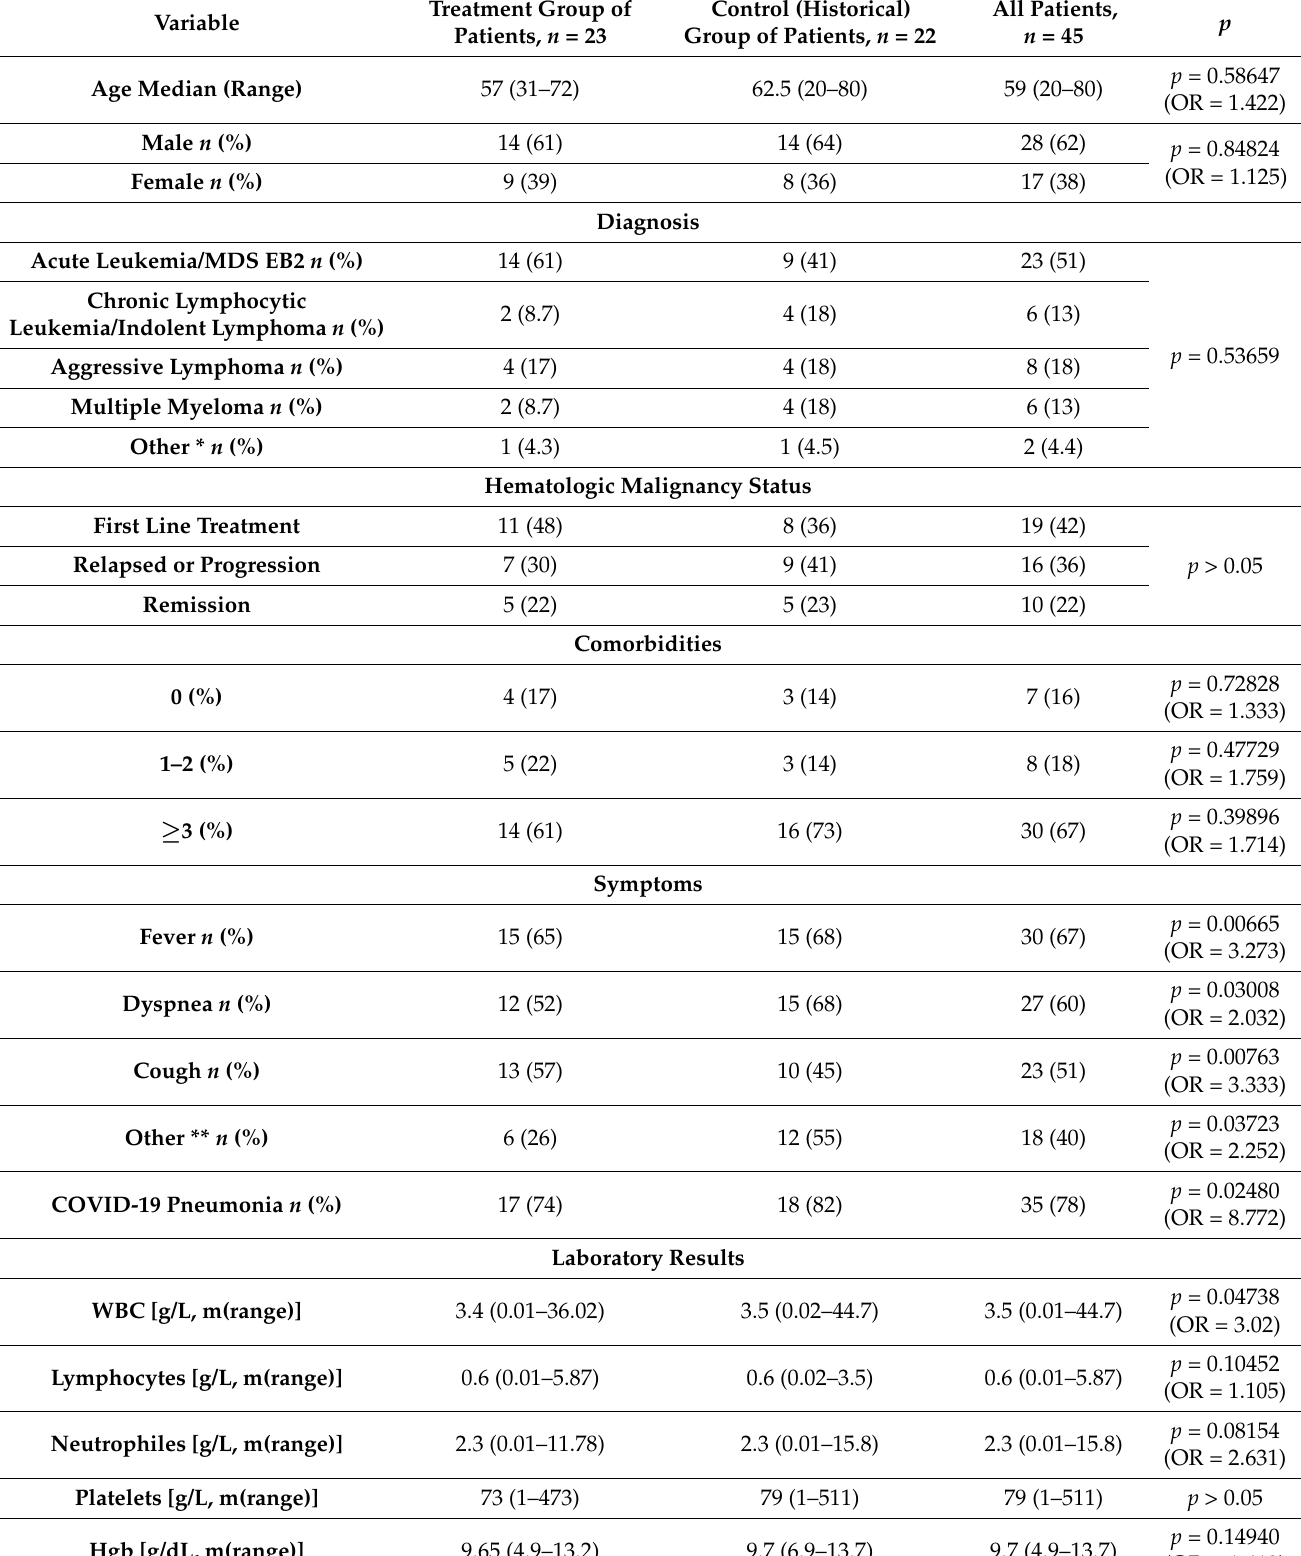
Table 1. Baseline clinical characteristics, laboratory data and outcome of patients with